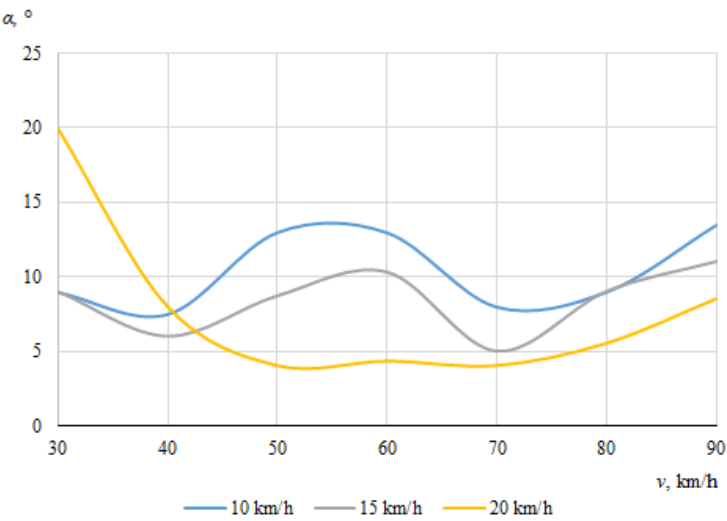
Figure 12. Bicycle throwing angle (impact angle 30°).